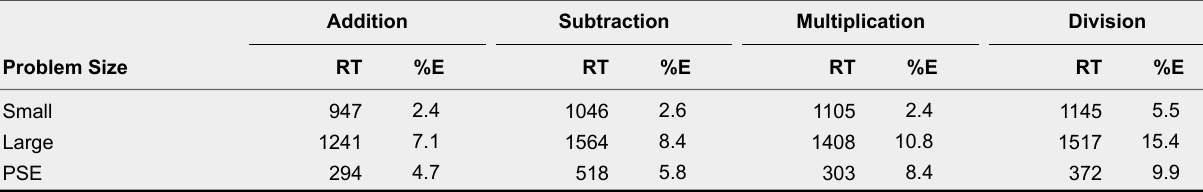
Mean Solution Latencies and Percentage Errors by Problem Size and Operation